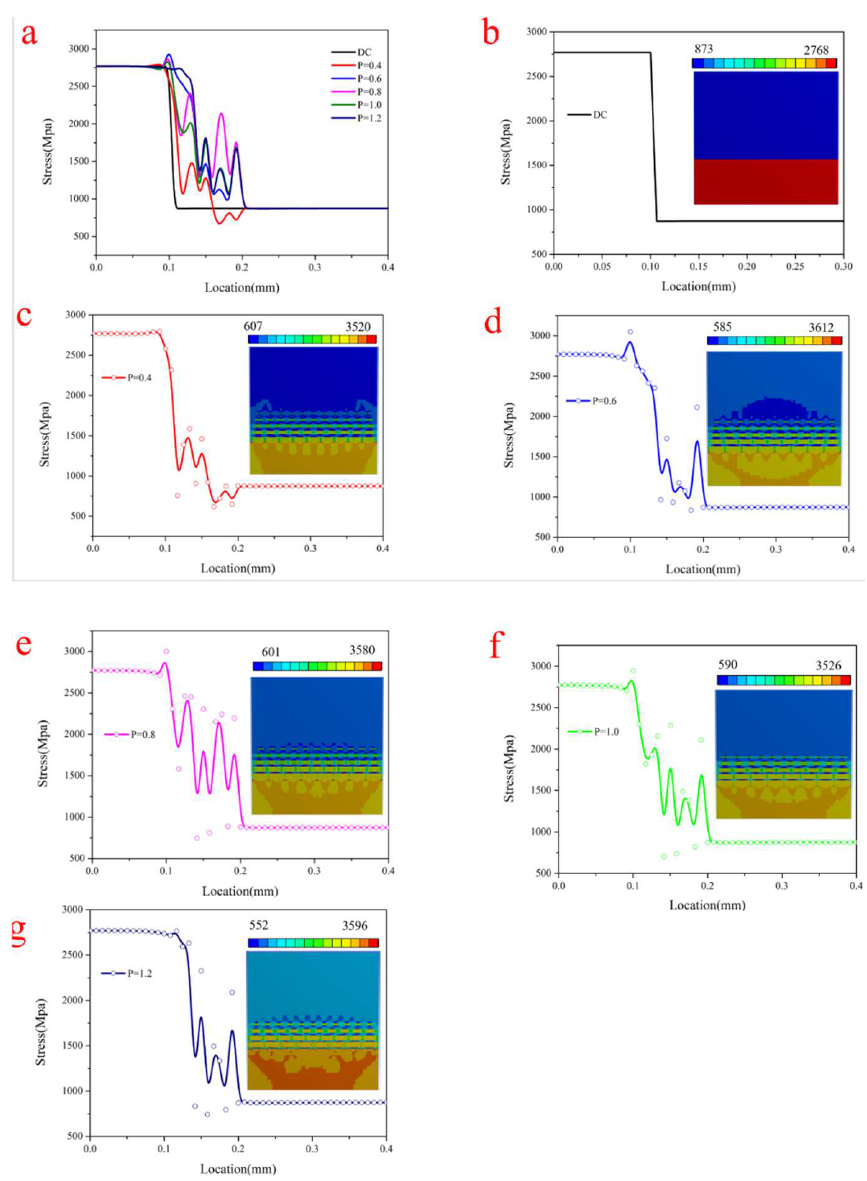
Figure 6. Stress distribution of the model along the vertical axis of symmetry ( a ), thermal stress distribution of traditional coating ( b ) and S2 ( c – g ).